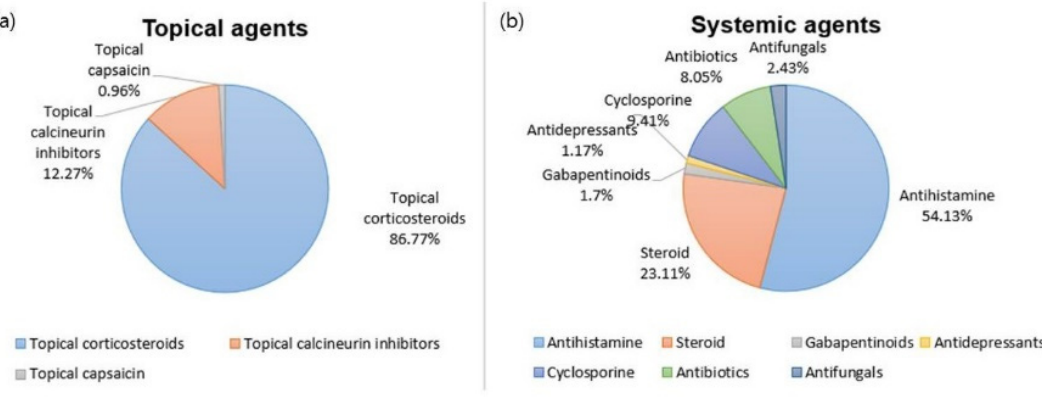
Figure 2. Prescription patterns for PN: ( a ) topical agents, ( b ) systemic agents.